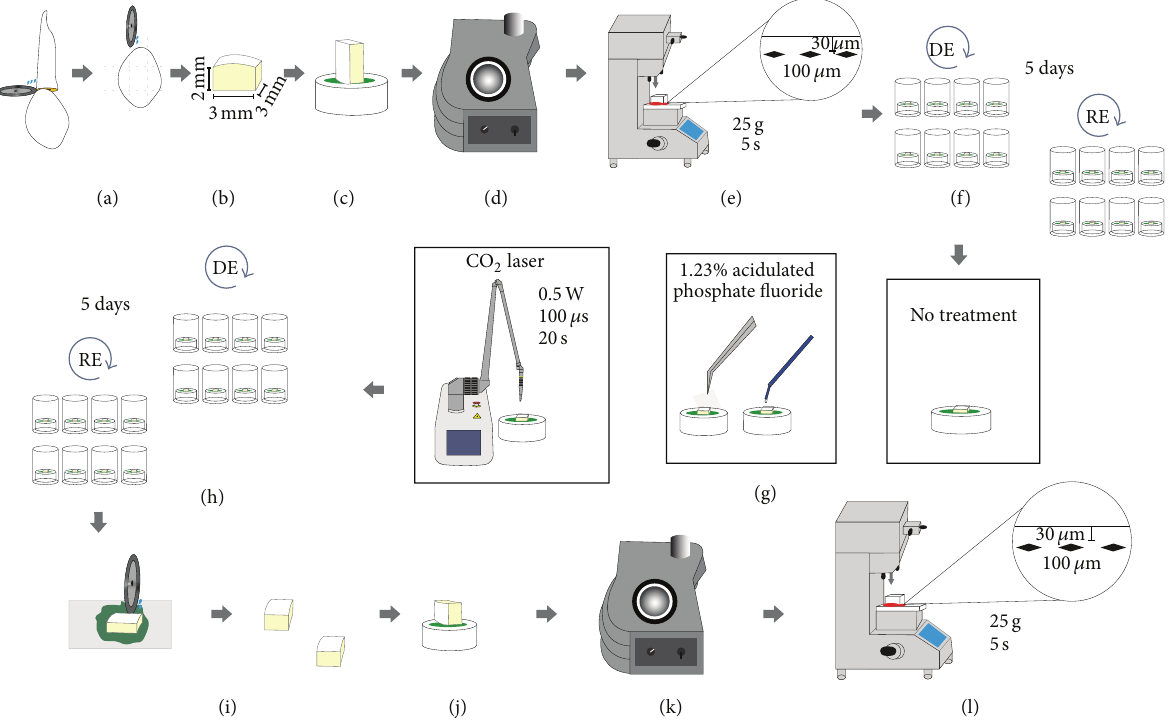
Figure 1: Schematic design of the methodology presented. (a) Section of the teeth. (b) Obtaining fragments. (c) Fixation of specimens in resin blocks. (d) Planning and polishing the enamel surface. (e) Selection of specimens. (f) Initial cariogenic challenge. (g) Surface treatments. (h) Cariogenic challenge after surface treatment. (i) Section of the fragments. (j) Fixing the fragments into blocks of acrylic resin. (k) Polishing the enamel surface. (l) Microhardness